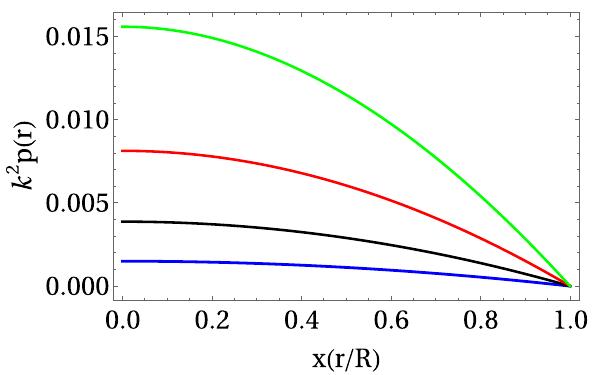
Fig. 3 Radial pressure for Model I for compact factors: 0.1 (blue line), 0.15 (black line), 0.20 (red line) and 0.25 (green line)